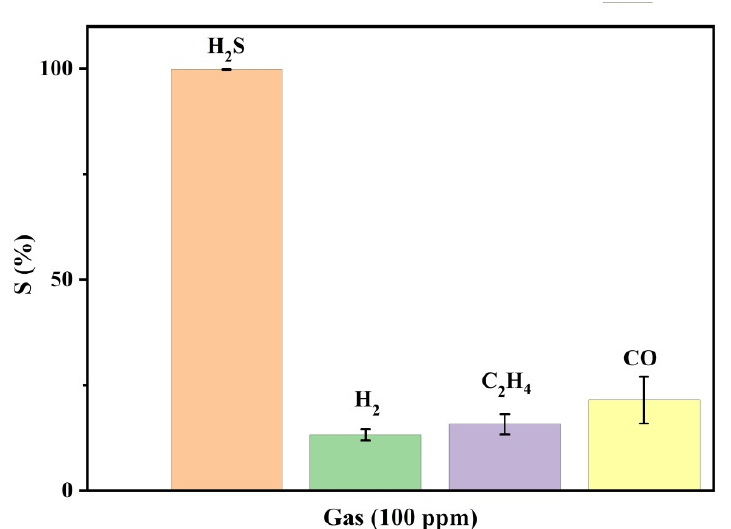
Figure 7. Selectivity of the ZnO/PVA/IL membrane to 100 ppm of H 2 S compared to H 2 , C 2 H 4 , CO gases at 100 ppm.